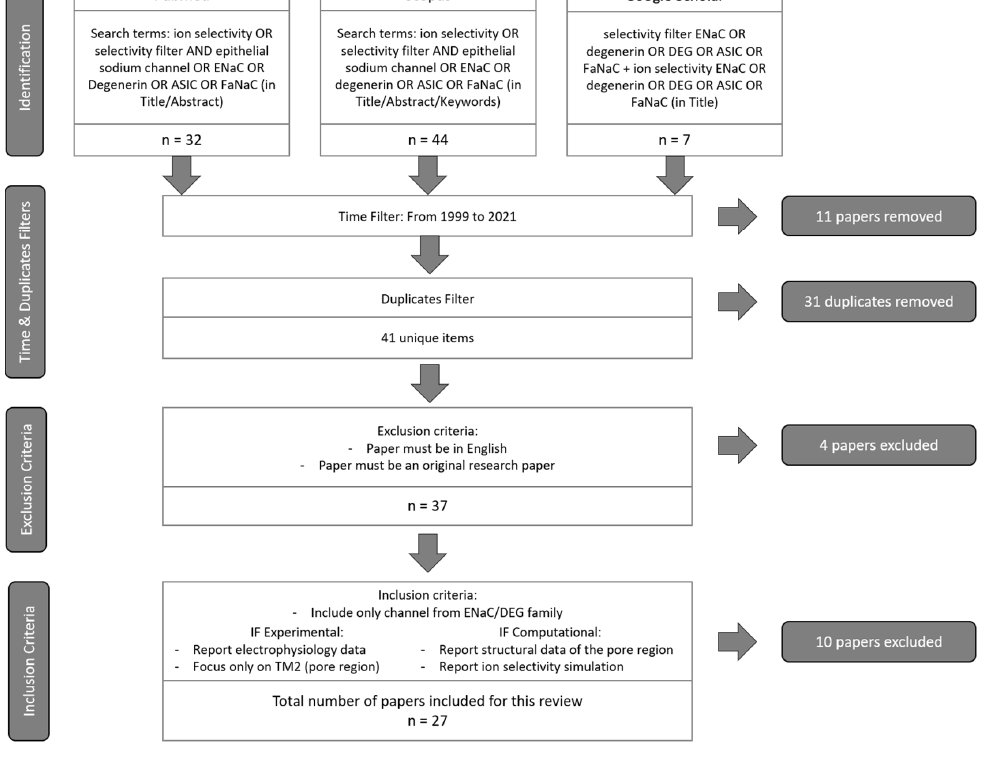
Main Outcome of the Study